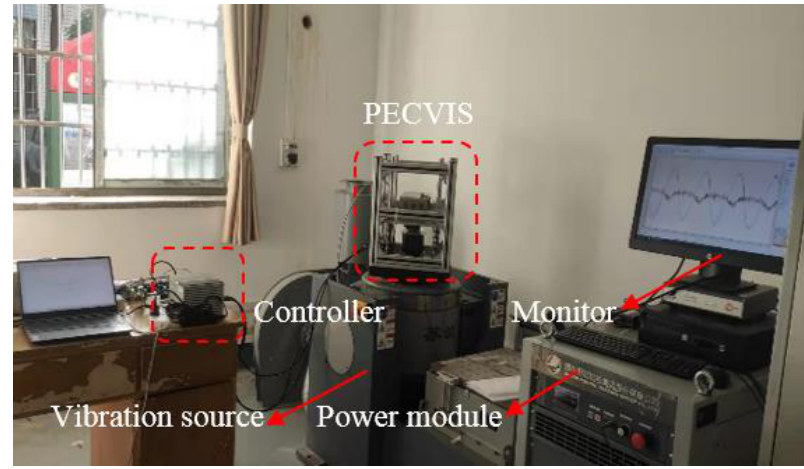
Figure 14. Photograph of PECVIS test platform. Table 10. Vibration isolation effect of mechanical spring and PECVIS.